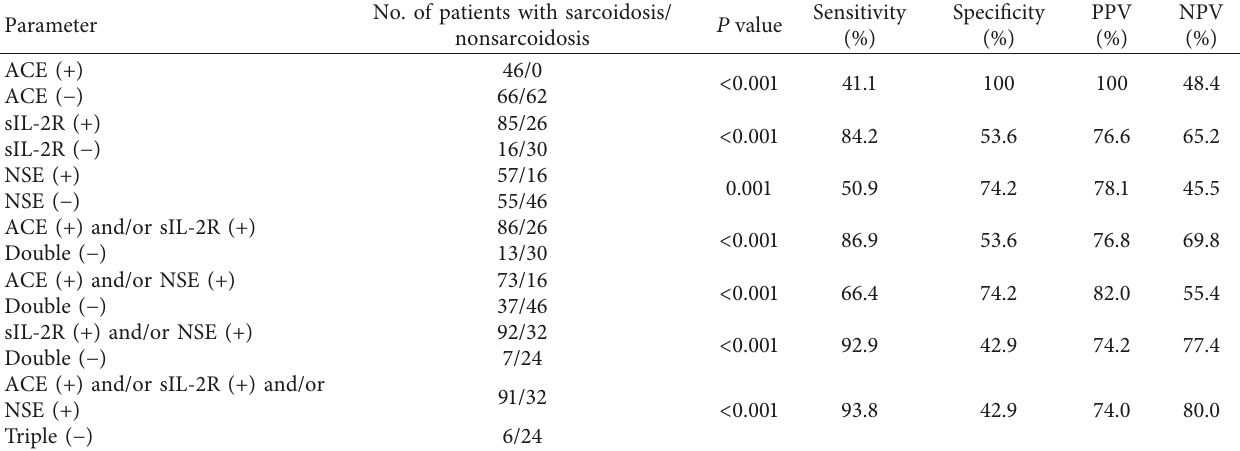
Table 2: Diagnostic significance of ACE, sIL-2R, NSE, and the combination for sarcoidosis. No. of patients with sarcoidosis/ Parameter